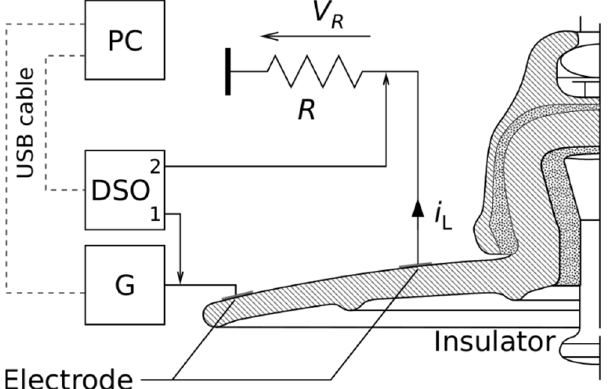
Figure 4. Leakage current and electric charge measurement diagram.